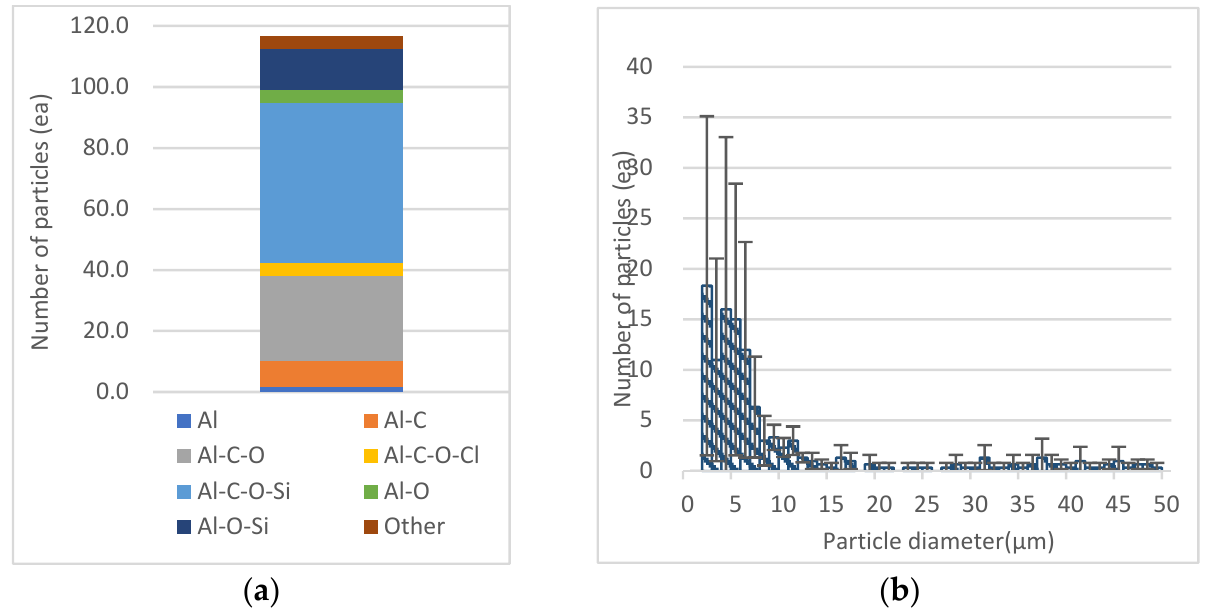
Figure 7. Composition of chemical categories and number of total Al particles: ( a ) Composition of chemical categories; ( b ) number of total Al particles by aerodynamic diameter ( μ m).